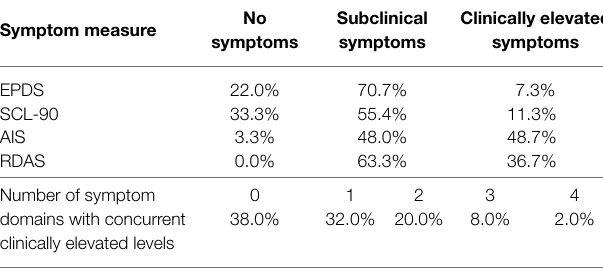
TABLE 2 | Frequency of clinically elevated symptom domains in the study